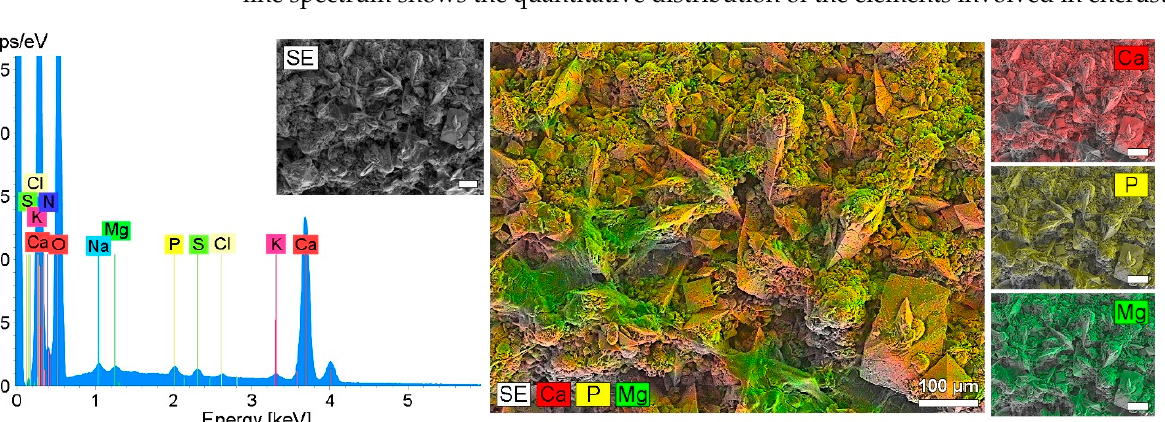
Figure 13. Encrustations on an implant from the urinary bladder of a rat, indwelling time 21 days. Elastollan + barium sulphate + a-C:H/Cu-mulitilayer coating. EDX line spectrum with SEM of the encrustation and element distribution of Ca, P and Mg encrustation by EDX mapping and merged image. FE-SEM Merlin VP compact (Zeiss, Germany) with EDX detector XFlash 6/30 (Bruker, Bremen, Germany).